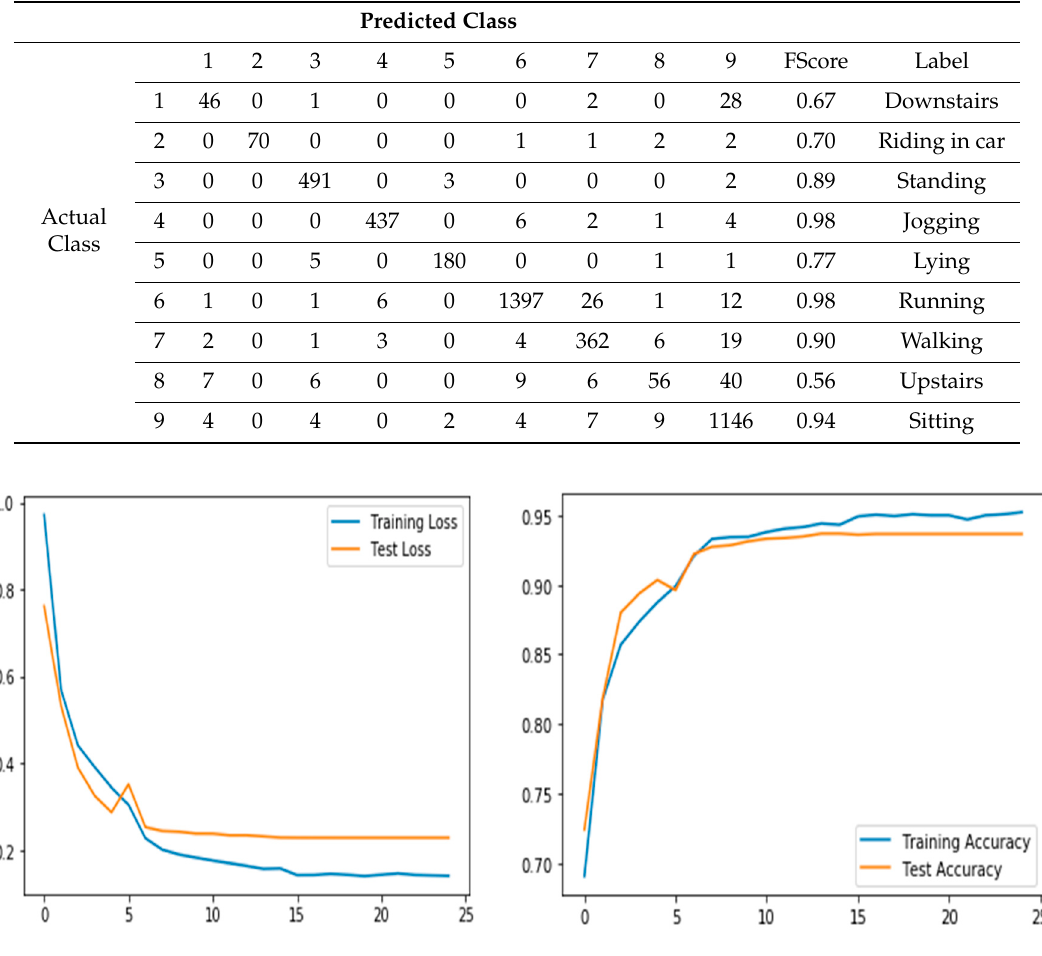
Table 2. Confusion Matrix for Inertial Sensing.